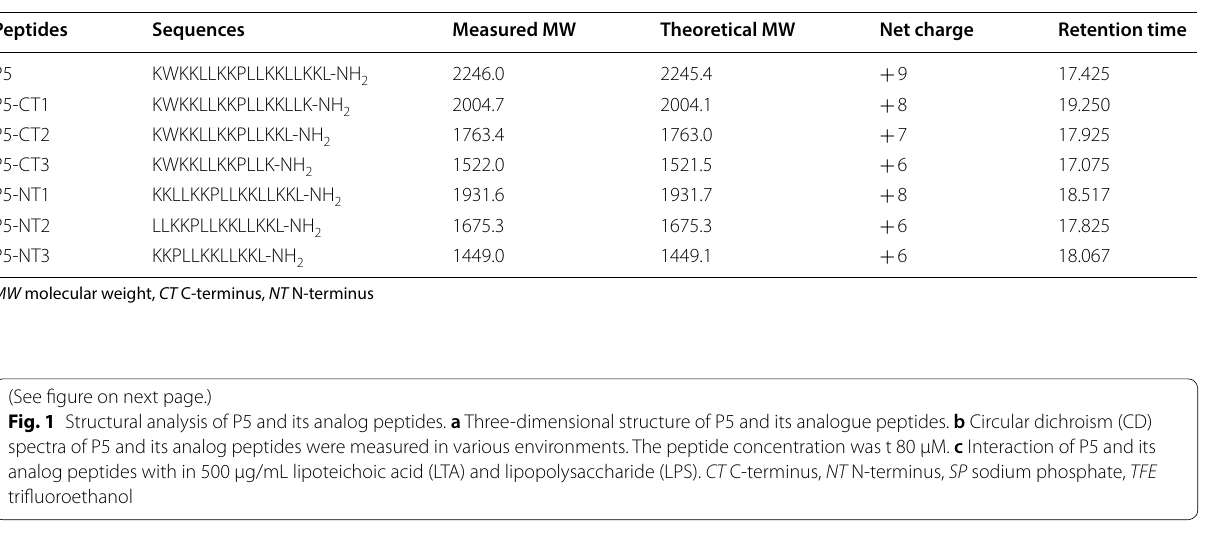
Table 1 Amino acid sequences and physicochemical parameters of parent and truncation peptides